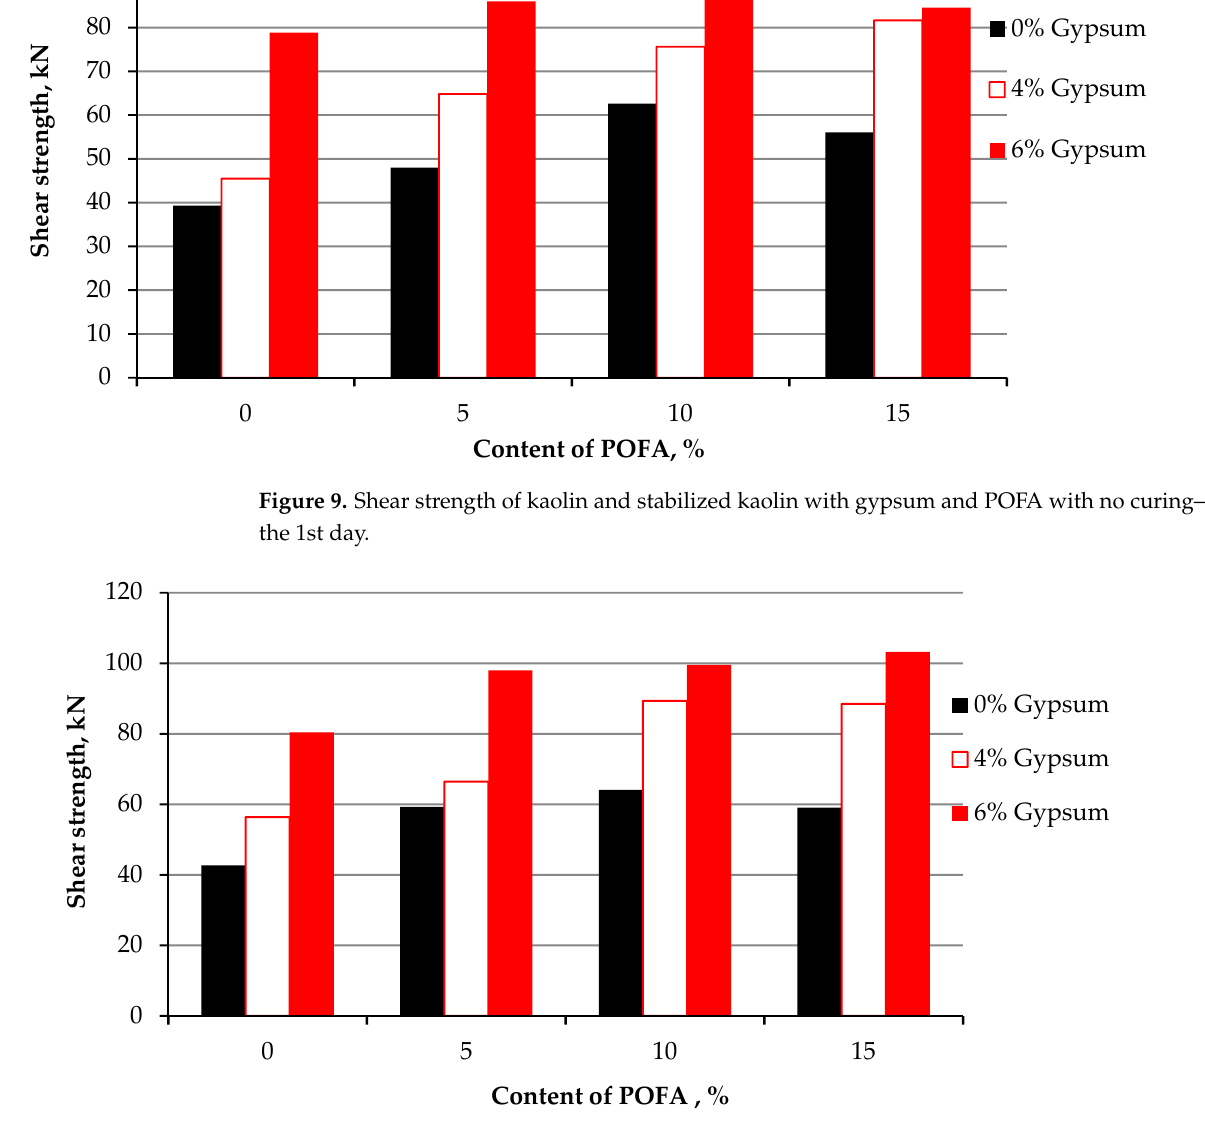
Figure 10. Shear strength of kaolin and treated kaolin with gypsum and POFA tested after 1 day of curing. Table 4. Summary of variance and standard deviation of the specimen of shear strength after one day